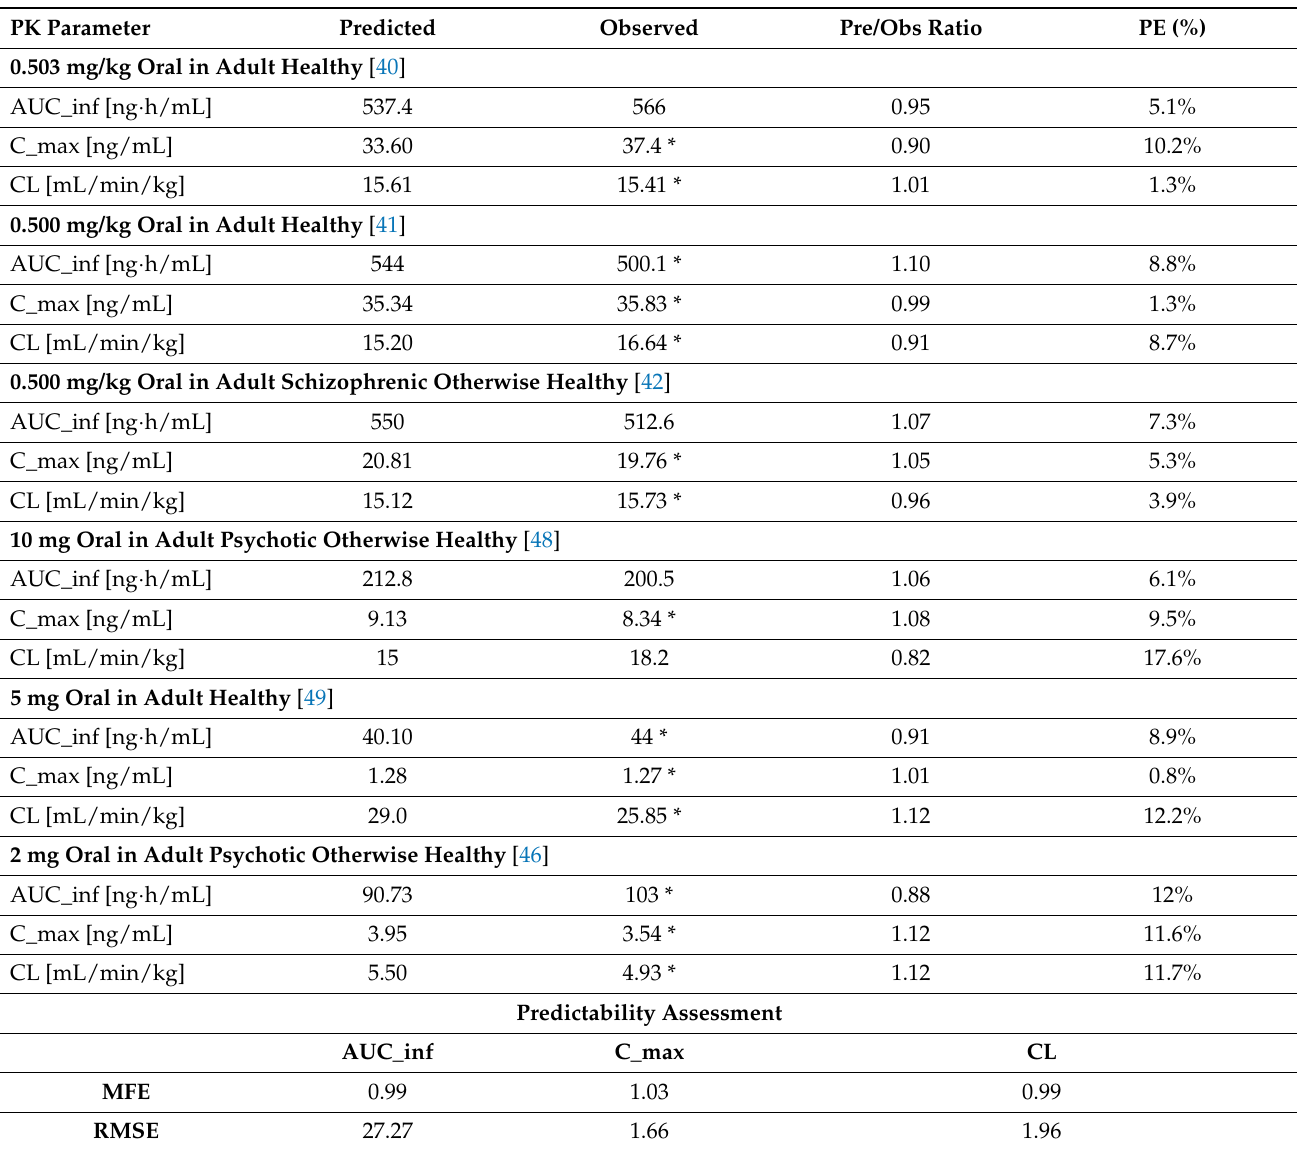
Table 5. Pharmacokinetic analysis of simulated and observed values after oral administration of haloperidol in healthy and psychotic otherwise healthy